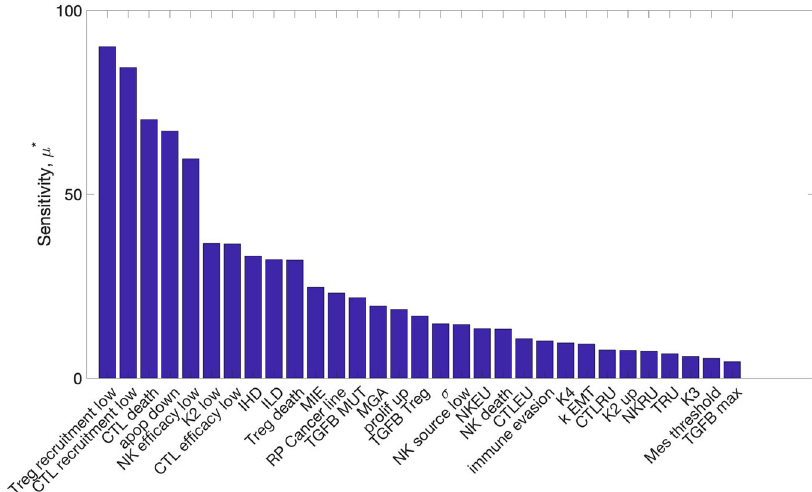
Fig. 2 Global sensitivity analysis of model parameters. The sensitivity ( μ *) denotes the average absolute change in the time to invasion over the range of variation of the